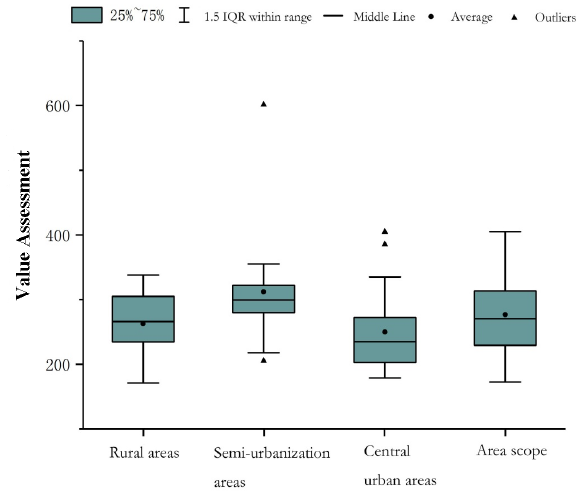
Figure 4: PER value from different soil types.